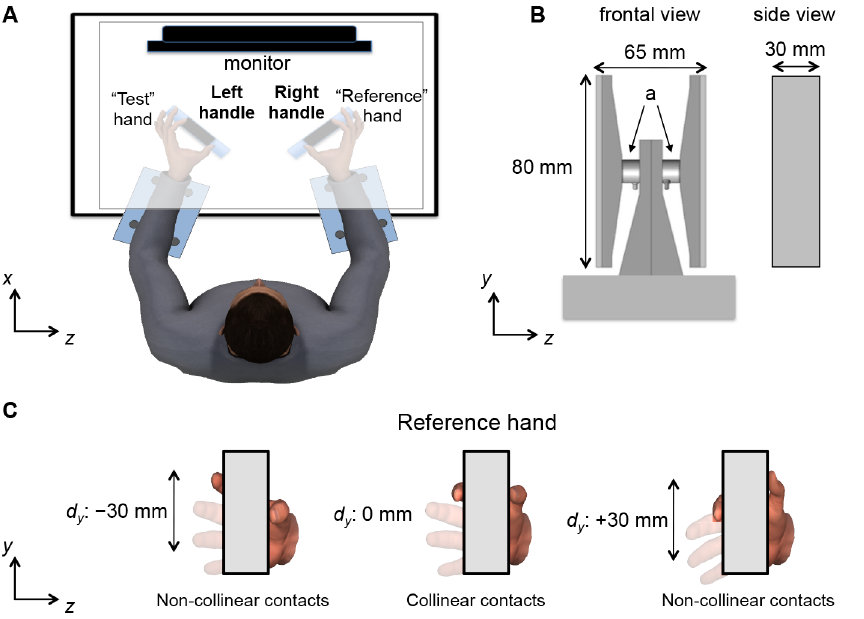
Figure 1. Experimental setup. Panel A shows a top view of the experimental setup. In this figure, the subject is shown performing the matching task using the left hand (‘‘Test’’ hand) to reproduce the vertical distance ( d y ) between the thumb and index finger pad of the right hand (‘‘Reference’’ hand) (see text for more details). Note that the table top (gray) prevented the subjects from seeing their forearms and hands but is shown as transparent for graphical purposes only. Forearms and wrists were strapped to the table to prevent movements within and across trials while the handles were anchored to the table. Panel B shows a frontal view of one of the two handles used for the study (‘‘ a ’’ denotes force/torque sensors). Panel C shows the frontal view of the handle with the three d y s of the reference hand used for the study. Note that d y is defined as positive or negative when the thumb pad is higher or lower than the index finger pad, respectively.